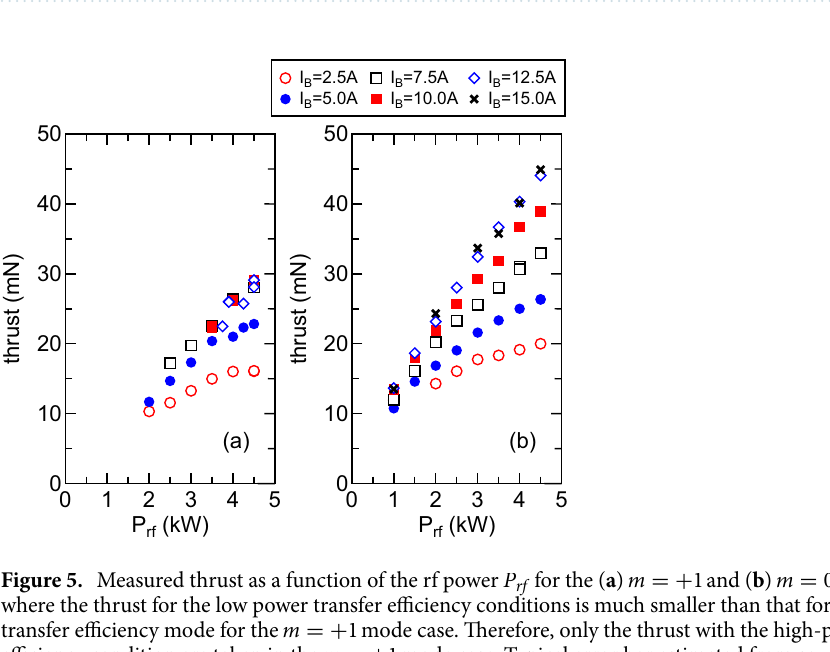
Figure 5. Measured thrust as a function of the rf power P rf for the ( a ) m where the thrust for the low power transfer efficiency conditions is much smaller than that for the high power transfer efficiency mode for the m efficiency condition are taken in the m 3 – 5% ±